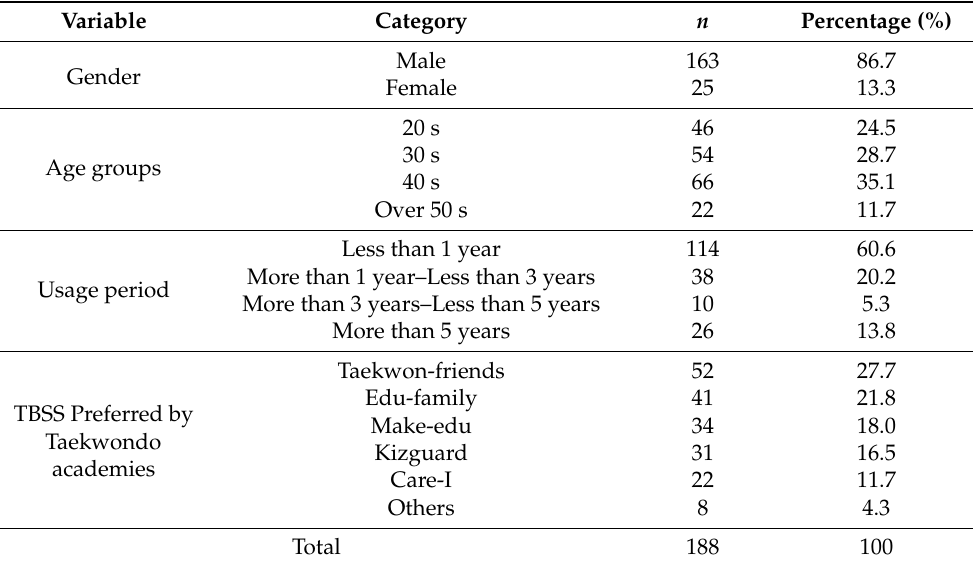
Table 1. General characteristics of the study